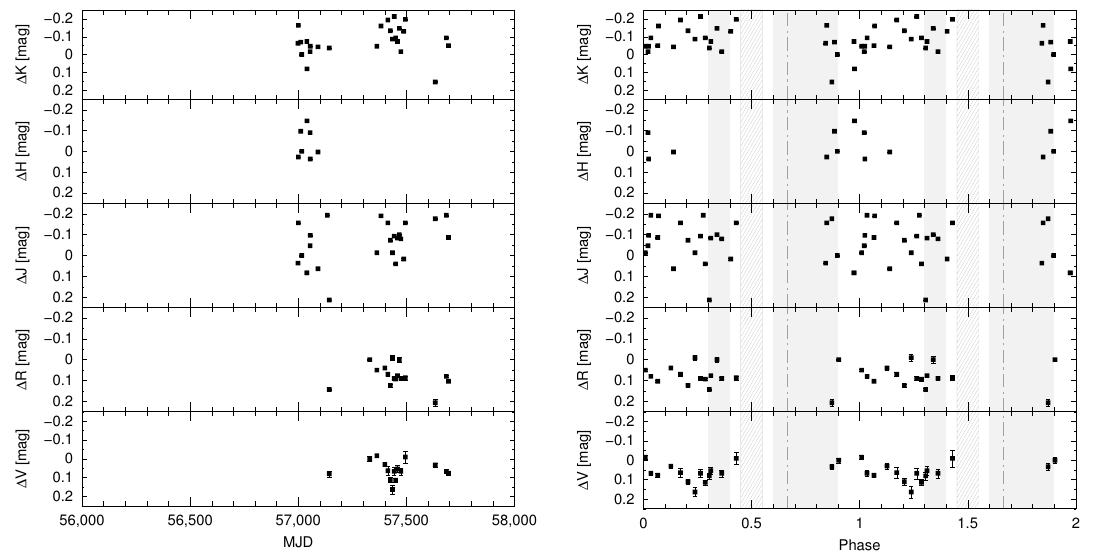
Figure 9. The same as Figure 3, but for HESS J0632 + 057 with Kanata/HONIR. See Figure 5 for the shaded and striped area.